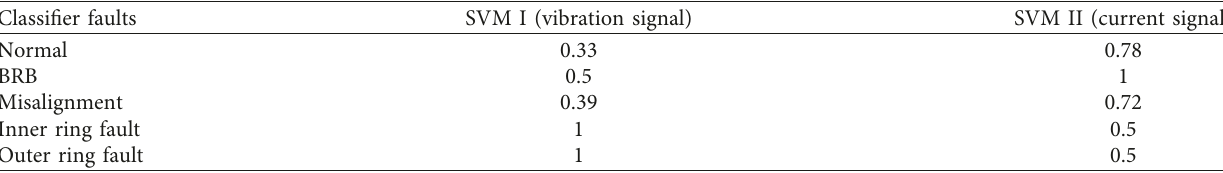
Table 10: Definition of fuzzy measures.